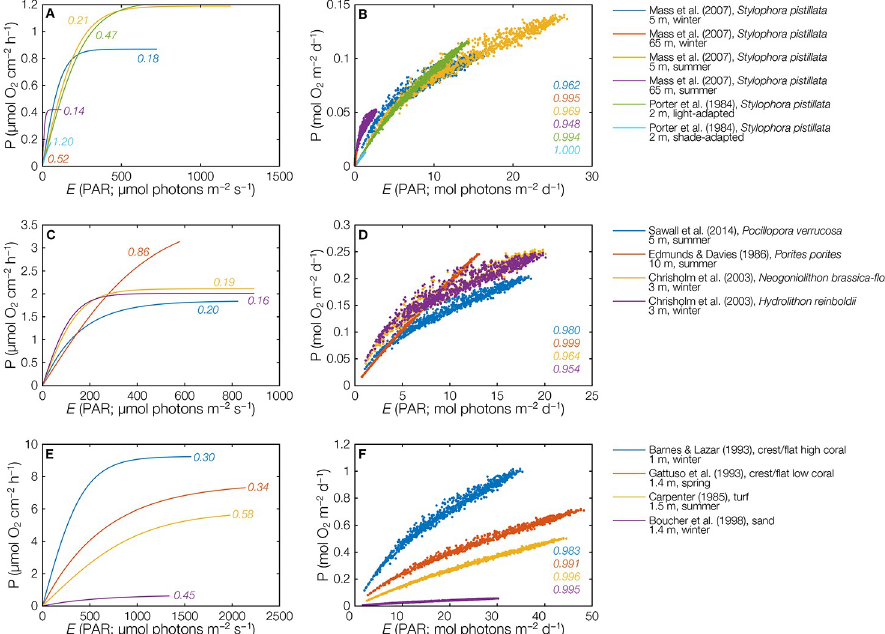
Fig 2. Instantaneous P-E curves (left column: A, C, E) and corresponding time-integrated P-E curves (right column: B, D, F) of the coral species Stylophora pistillata (A, B), of different individual reef corals and algae (C, D) and of different reef communities (E, F). P = photosynthesis or productivity, E = irradiance, PAR = photosynthetically available radiation, values within the graphs A, C and E = E k /E max , values within the graphs B, D and F = correlation coefficient r